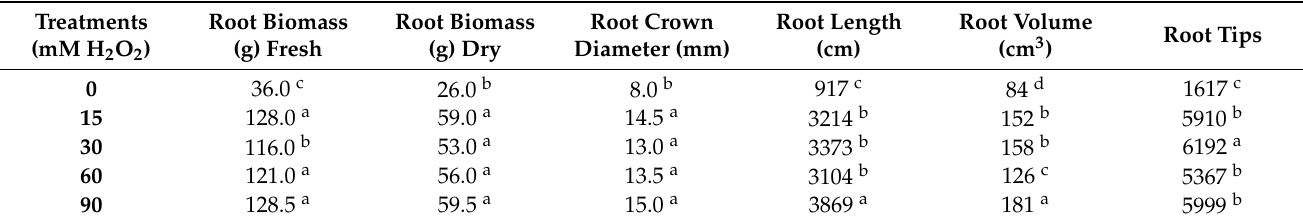
Table 3. Effects of different concentrations of H 2 O 2 on root biomass, root crown diameter, and root traits of F. deltoidea plants. Treatments (mM H 2 O 2